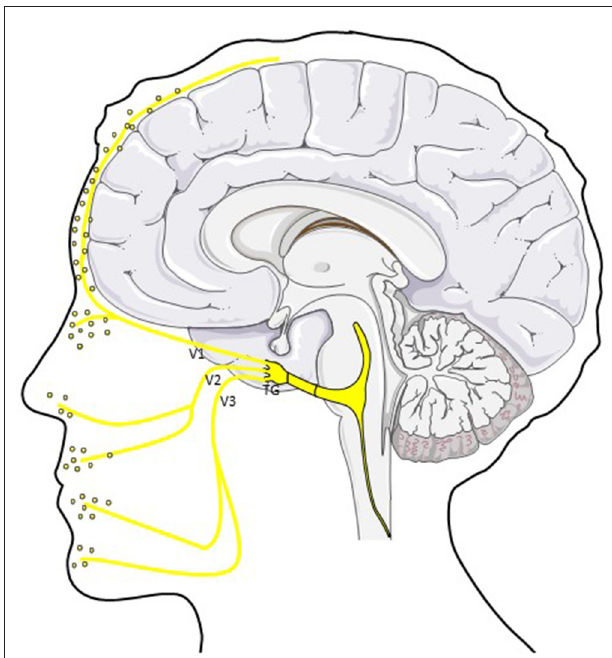
FIGURE 1 | CGRP in the trigemino-vascular system. CGRP is released from peripheral afferents of the ophthalmic (V1), mandibular (V2) and maxillary (V3) division of the trigeminal nerve. Different studies showed elevated CGRP levels in saliva and tear fluid in ictal and interictal migraine patients ( 40). TG; trigeminal